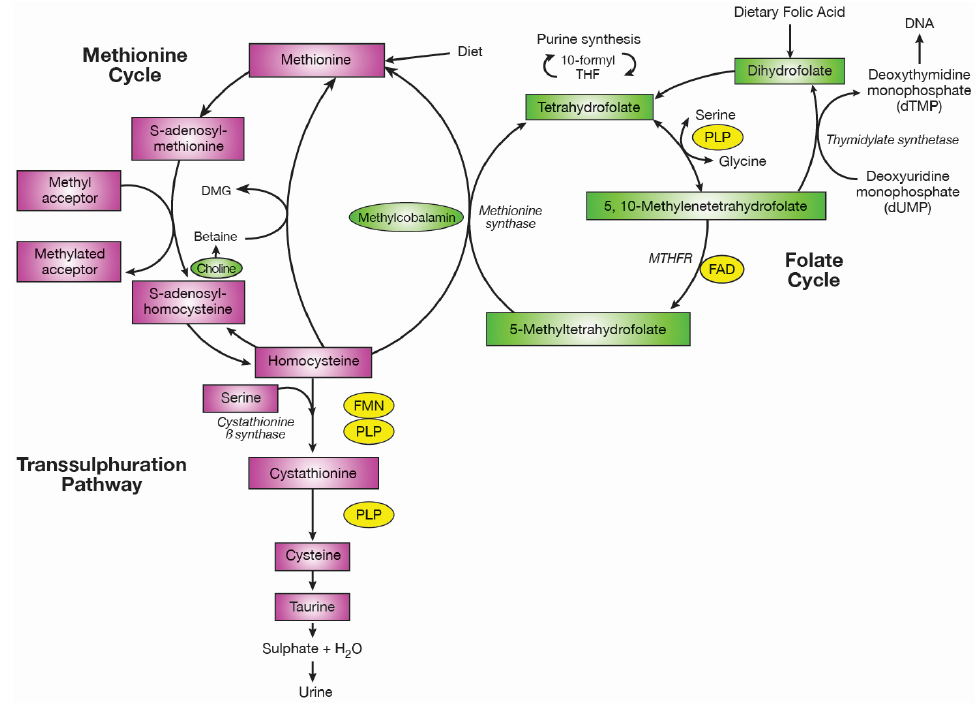
Figure 1. One ‐ carbon metabolism. Abbreviations: PLP, plasma pyridoxal phosphate; MTHFR, methylenetetrahydrofolate reductase; FAD, flavin adenine dinucleotide; FMN, flavin mononucleotide. Adapted from [16].